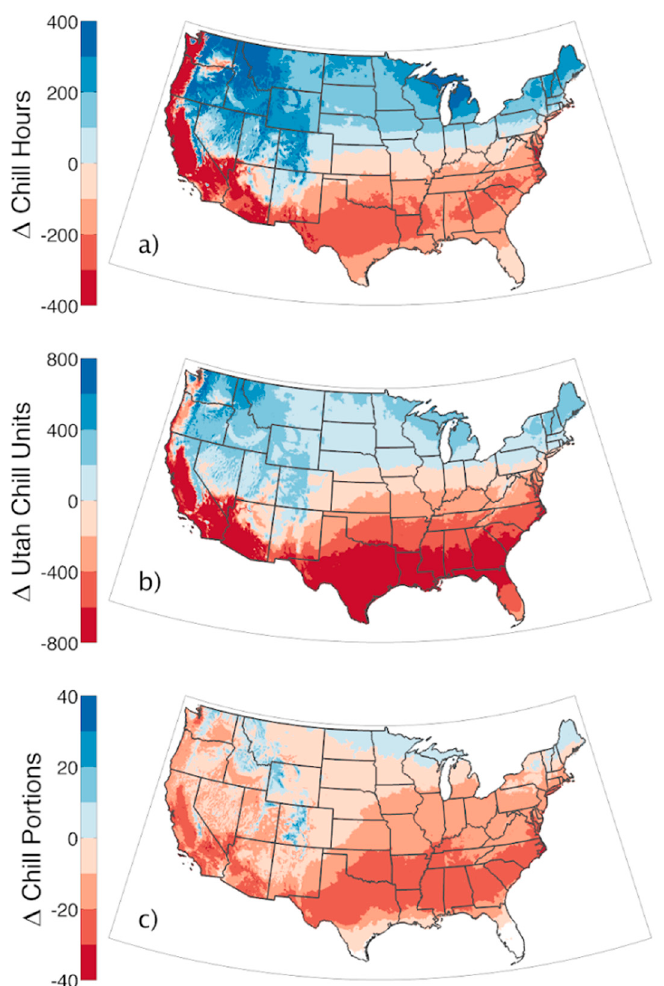
Figure 6. The 20-model average difference in annual accumulated chill between the modeled historical period (1971–2000) and the mid-century (2040–2069) period under RCP 4.5, where chill accumulation was calculated over the October 1 – April 30 cool season using ( a ) the Modified Chill Hour Model as chill hours 32–45 °C, ( b ) the Utah Model as chill units, and ( c ) the Dynamic Model as chill portions. The red shades indicate a reduction in chill accumulation under RCP 4.5, while the blue shades indicate an increase in chill accumulation. The white regions in ( c ) indicate areas with no chill accumulation under historical conditions. These data can be viewed and downloaded from the Climate Toolbox (https://climatetoolbox.org/) at ( a ) https://bit.ly/2QjbT2l ( b ) https://bit.ly/2AtEpZI and ( c ) https://bit.ly/2SBDcqm.